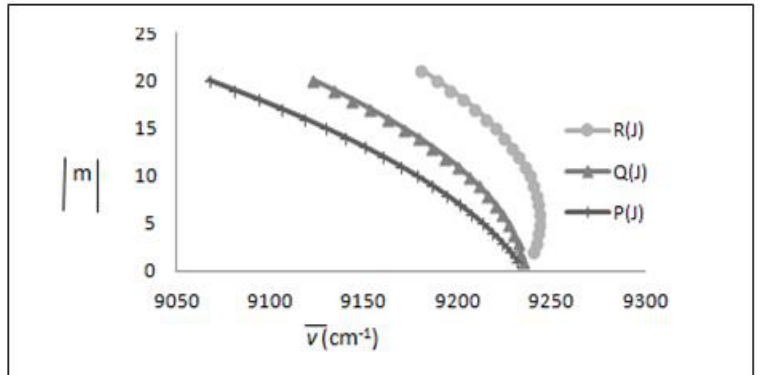
Fig.5: Fortrat parabola of BeO molecule for A 1 Π-X 1 Σ + system.